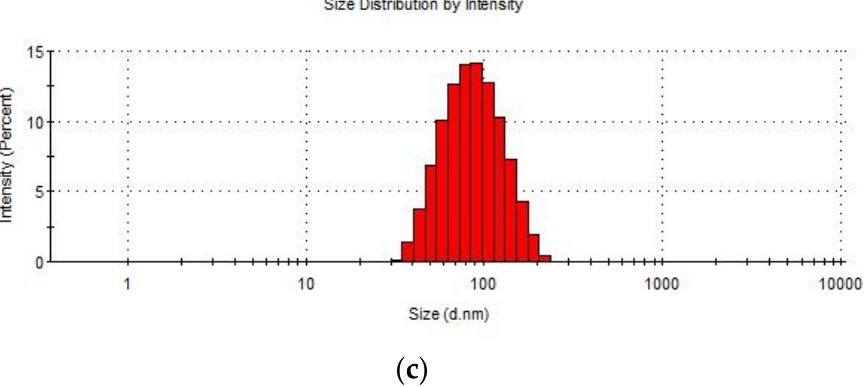
Figure 2. Size distribution of Cutibacterium acnes EVs. C. acnes EVs isolated from DSM 1897 type IA1 ( a ), EVs isolated from C. acnes DSM 16379 type IB ( b ), EVs isolated from C. acnes PCM 2334 type II ( c ).